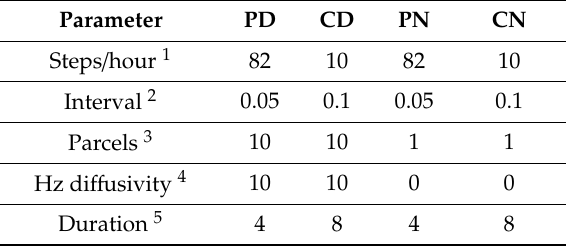
Table 2. Model parameters for numerical